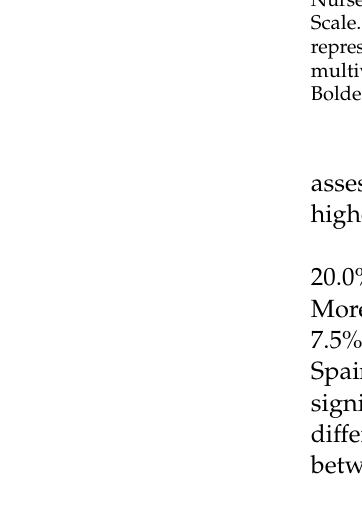
Table 3. Graduating nursing students’ intention to leave, analyzed with logistic regression ( n =